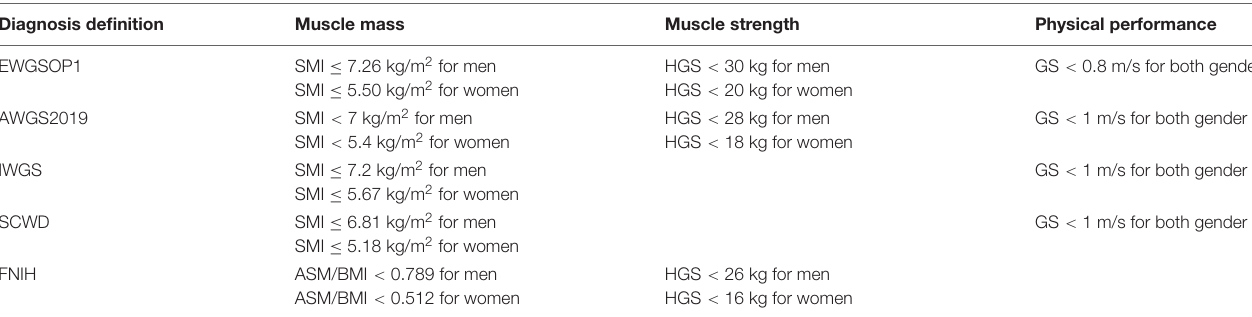
TABLE 1 | Five diagnostic criteria for sarcopenia and the cut-off applied. Diagnosis